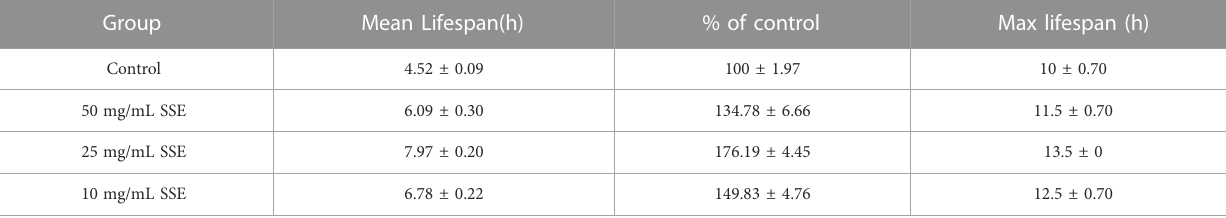
TABLE 2 Effects of SSE on the heat shock responses of Caenorhabditis elegans (mean ± SD, n = 3). Group